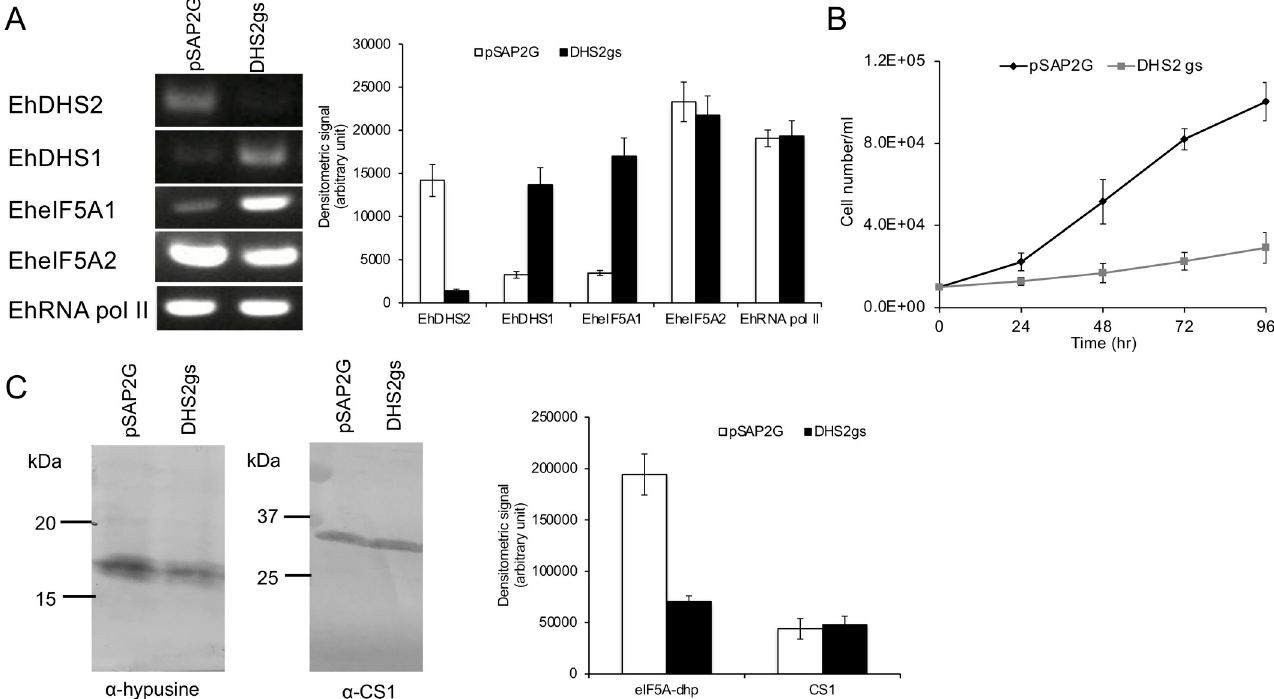
Fig 5. Effects of EhDHS2 gene silencing on gene expression of related genes and growth of E . histolytica trophozoites. (A) Evaluation of gene expression by semi-quantitative RT-PCR analysis of EhDHS2 gene silenced transformant. The steady-state levels of transcripts of EhDHS1 , EhDHS2 , EheIF5A1 , EheI5FA2 and EhRNA pol II genes were measured in trophozoites of G3 strain transfected with either empty vector (psAP2G) or the EhDHS2 gene silencing plasmid (psAP2G-DHS2). cDNA from the generated cell lines (psAP2G and DHS2gs strains) was subjected to 30 cycles of PCR using specific primers for the DHS2 , DHS1 , eIF5A1 , eI5FA2 and RNA pol II genes. RNA polymerase II served as a control. PCR analysis of samples without reverse transcription was used to exclude the possibility of genomic DNA contamination. The densitometric quantification of the bands, shown in the right graph, was performed by Image J software, and the expression level of EhDHS1 , EhDHS2 , EheIF5A1 , EheIF5A2 , and EhRNA pol II was expressed in arbitrary units. (B) Growth kinetics of control (pSAP2G) and EhDHS2 gene silenced (DHS2gs) transformants. Approximately 60,000 amoebae in the logarithmic growth phase were inoculated into 6 mL fresh culture medium and amoebae were then counted every 24 hr. Data shown are the means ± standard deviations of five biological replicates. (C) Immunoblot analysis of control (pSAP2G) and EhDHS2 gene silenced (DHS2gs) transformants using hypusine antibody. Total cell lysate was electrophoresed on a 15% SDS-PAGE gel and subjected to an immunoblot assay with hypusine antibody and CS1 (loading control) antiserum. The intensity of the bands corresponding to hypusinated EheIF5A and CS1 was measured by densitometric quantification, analyzed by Image J software, and is shown in arbitrary units in the right graph.